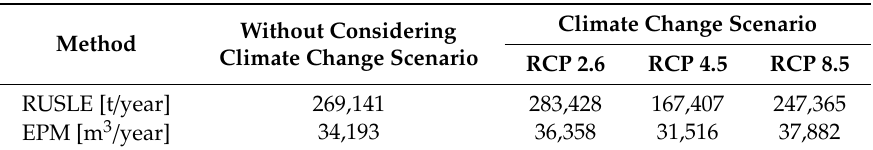
Table 9. Summary of the